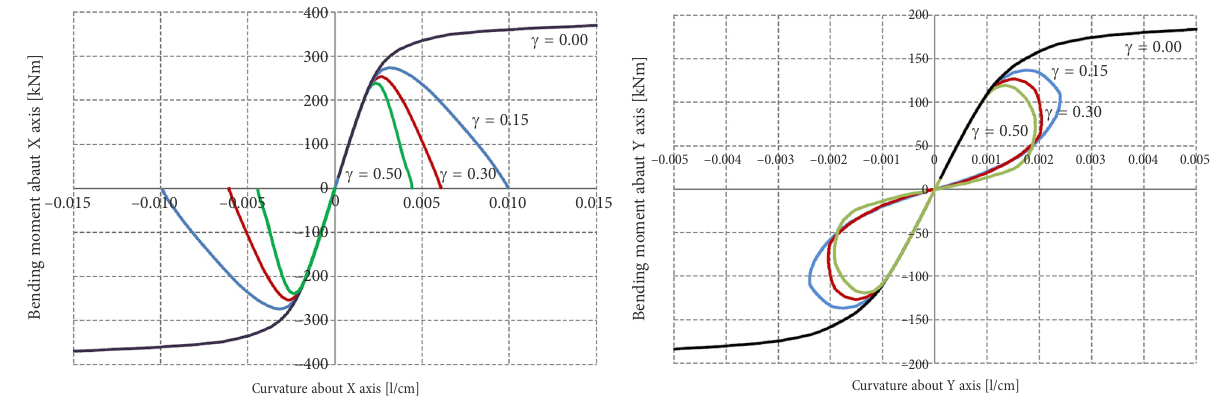
Fig. 16. Moment curvature diagrams for different values of degree of confinement and compressive axial force of N = 6000 kN and a = 26.56 ° : Bending moment about X -axis (strong axis)